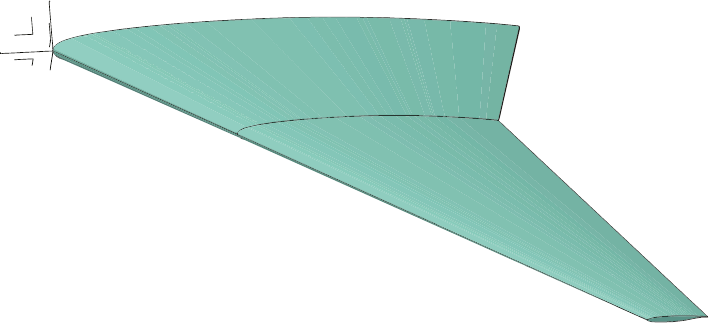
Figure 1: Swept-wing model.